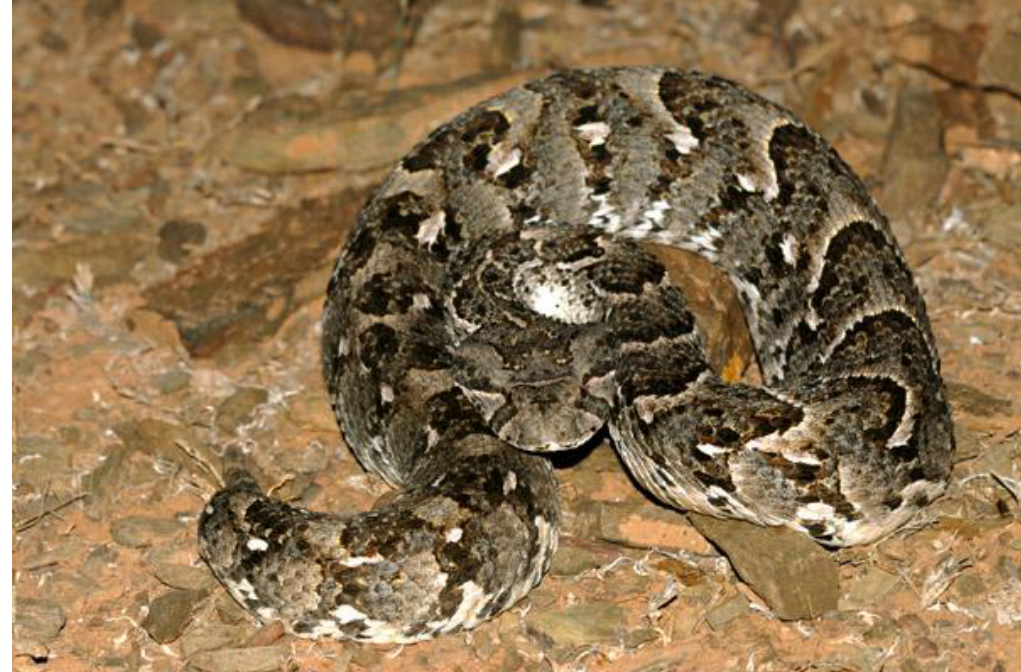
Figure 2. Puff adder ( Bitis arietans ), environs of Fort Bou-Jérif, west of Guelmim, Morocco (photo by M. Aymerich,